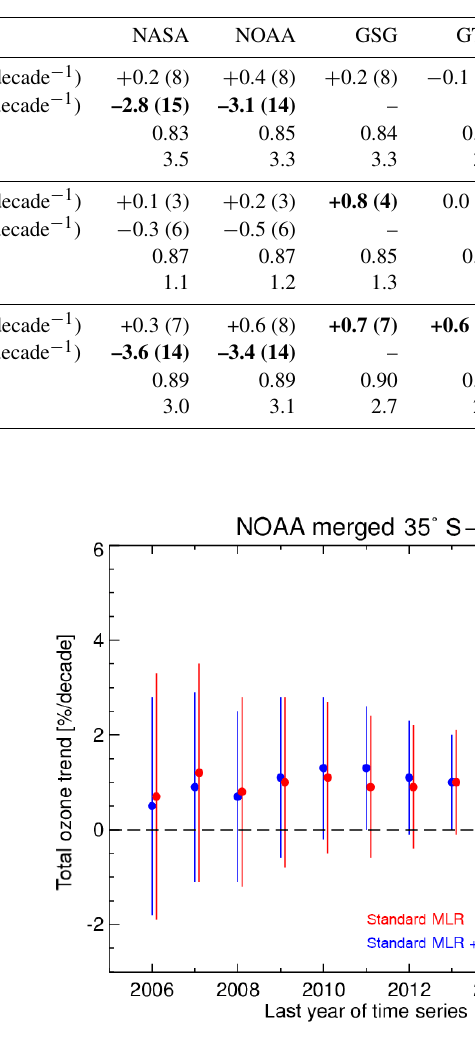
Figure 4. The dependence of the post-ODS peak trends in the NH extratropics from the end year in the MLR. The vertical bars show the 2 σ uncertainties of the trends. Red symbols are the results from the standard MLR fit (Eq. 1 with P(t) = 0) and blue from the ex- tended MLR that includes the AO and NH BDC terms (see Eq. 4).